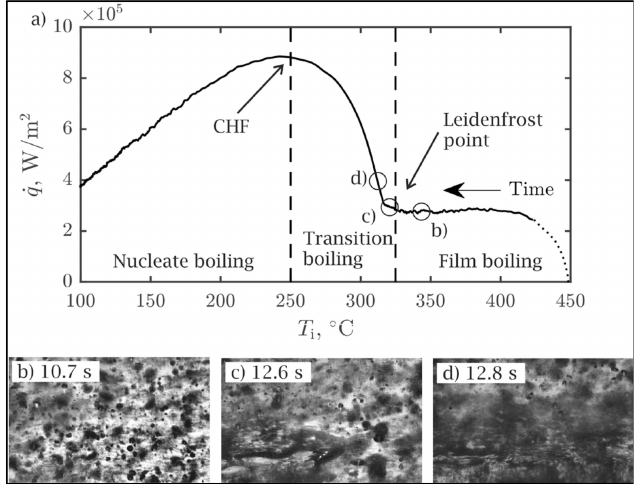
Figure 1. ( a ) Phenomena of spray impact regimes at different wall temperatures, plotted against the measured heat flux of the wall. ( b ) Picture of drop rebounds from the wall with a temperature higher than Leidenfrost point. ( c , d ) Pictures of wetted spots of boiling liquid with a wall temperature below Leidenfrost point. With permission from